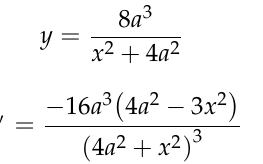
Table 3. Comparison of combustion chamber parameters before and after